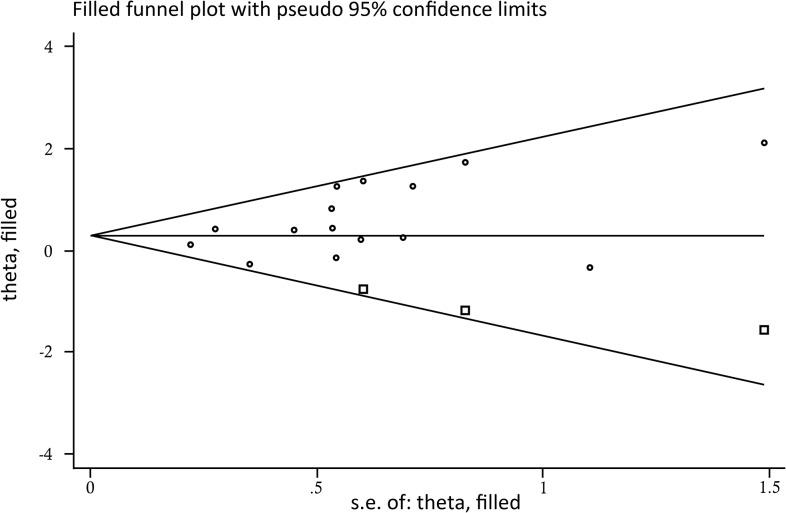
Begg’s funnel plot for the effect of rs861539 on radiation-induced adverse effects.Circles represent the actually included studies. Squares represent studies added using the “trim and fill” method.